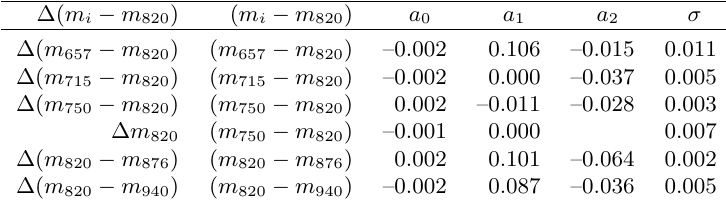
Table 2. Coefficients of Equation (2) and the accuracy of decontamination corrections for six passbands constructed from the simulated Gaia RP spectra (without M stars, with interstellar reddenings up to A V = 3 mag).